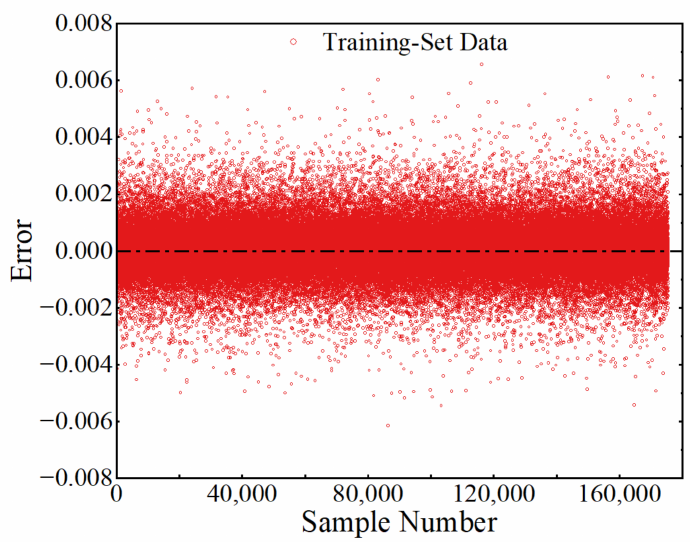
Figure 13. Errors of the ANN in predicting the training-set samples.